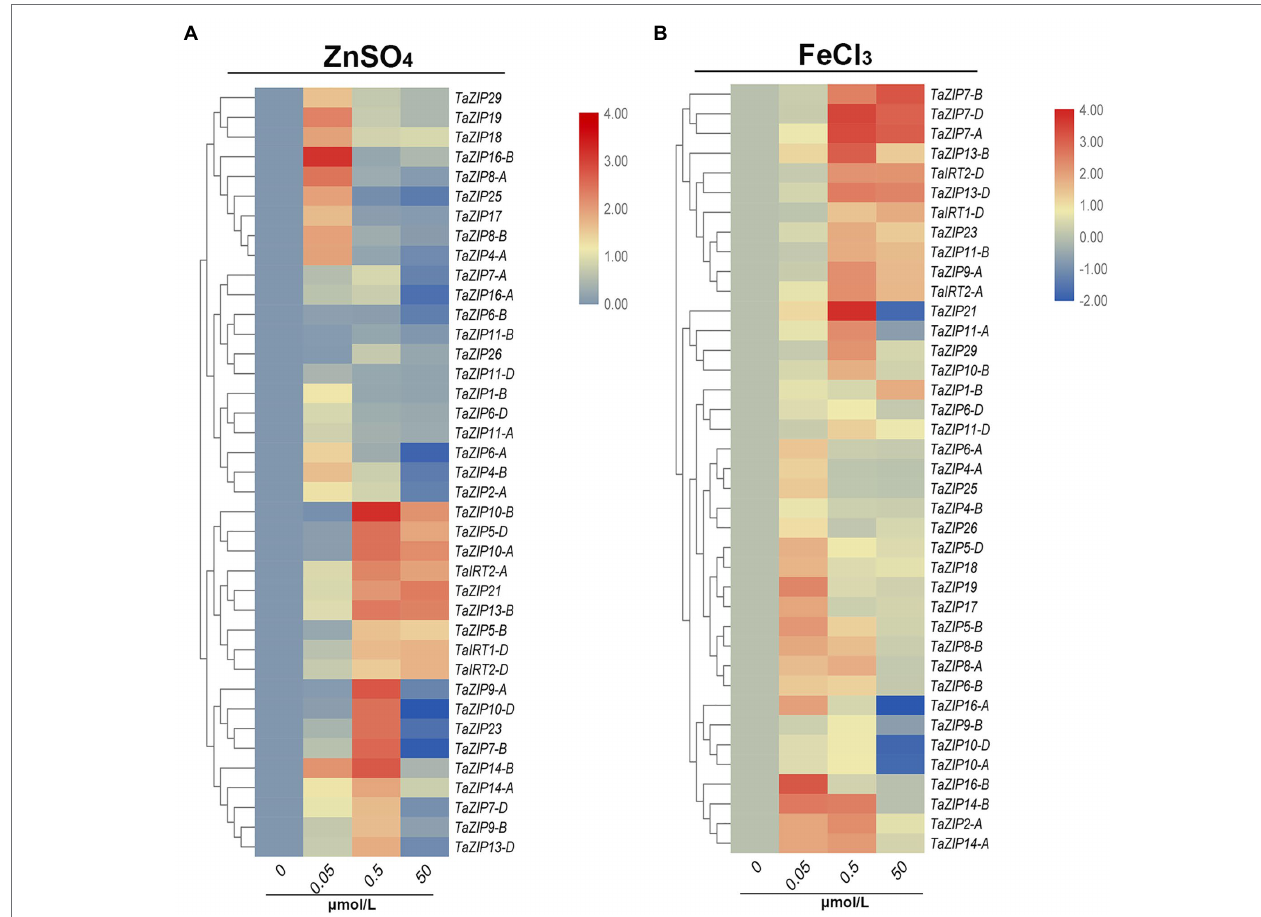
FIGURE 5 | Expression profiles of TaZIP genes under Zn or Fe stress through qRT-PCR analysis. The wheat seedling at two leaf stage of genotype Xiaobaimai were treated under standard nutrient condition (CK), 0.05, 0.5, 50 ZnSO 4 (A) and FeCl 3 (B) and the samples were harvested at 1 h after treatment. Data from qRT-PCR were analyzed according to the 2 −∆∆ C t method. Relative mRNA abundance of each gene was normalized with TaActin gene. The error bars indicate standard